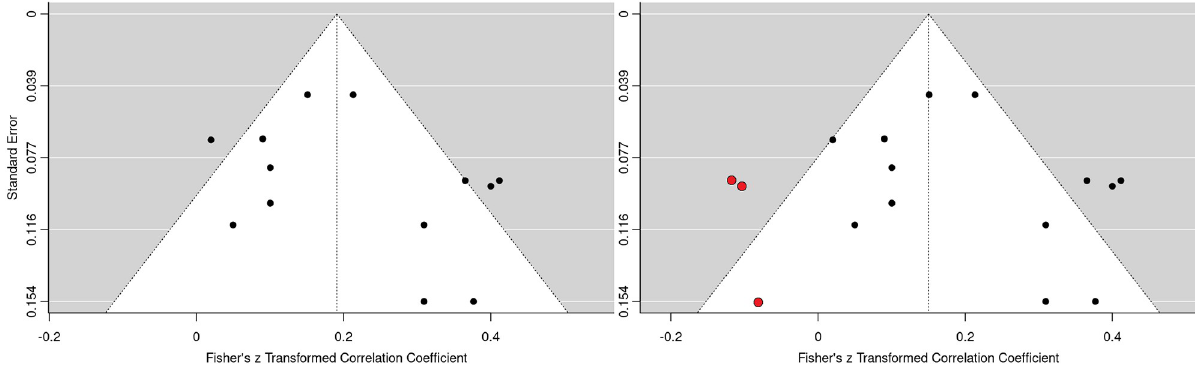
Fig 3. Funnel plot (left) with trim and fill applied